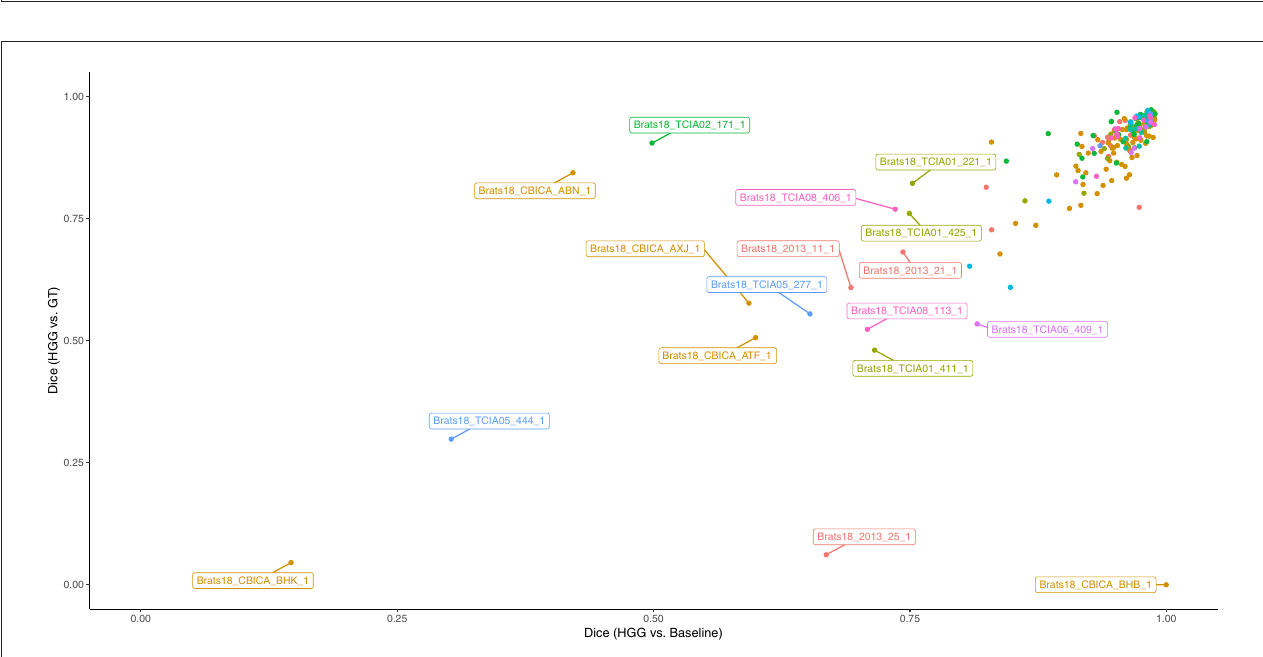
tumor mass in the frontal lobe. Furthermore, we argue that a large part of the lesion corresponds to non-enhancing tumor rather than edema. We base this assumption on the heterogeneous appearance in the T2-weighted images and more importantly the strong cortical space-occupying effect together